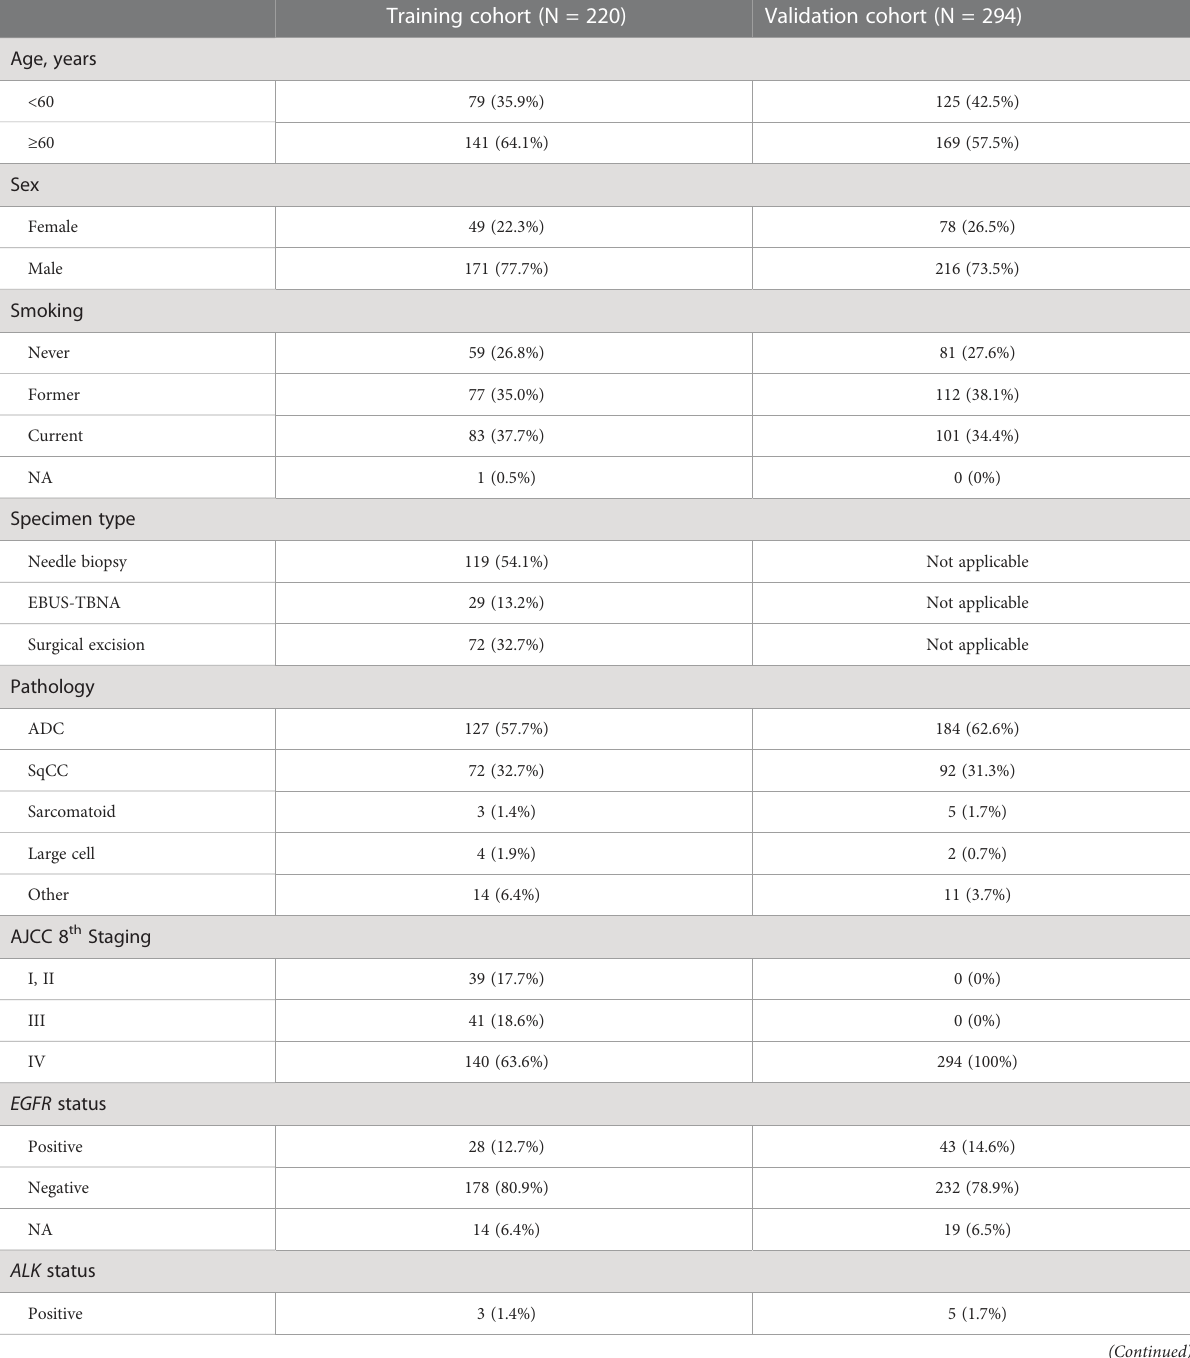
TABLE 1 Demographic characteristics of samples included in the